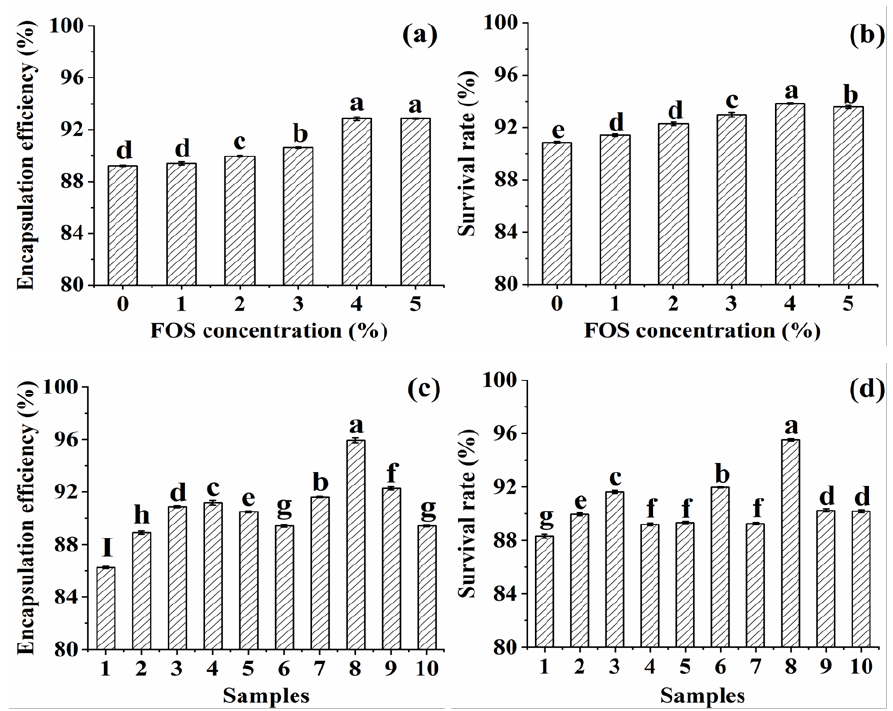
Figure 1. Effects of FOS ( a , b ) and the complex of fish oil and FOS ( c , d ) on the EE ( a , c ) and SR ( b , d ) of probiotics. Different lowercase letters above the column indicate a significant difference between samples ( p < 0.05). (Samples 1: no addition substrate, samples 2 – 4: 10 µL fish oil + 2% or 3% or 4% FOS; samples 5 – 7: 15 µL fish oil + 2% or 3% or 4% FOS; samples 8 – 10: 20 µL fish oil + 2% or 3% or 4% FOS.).